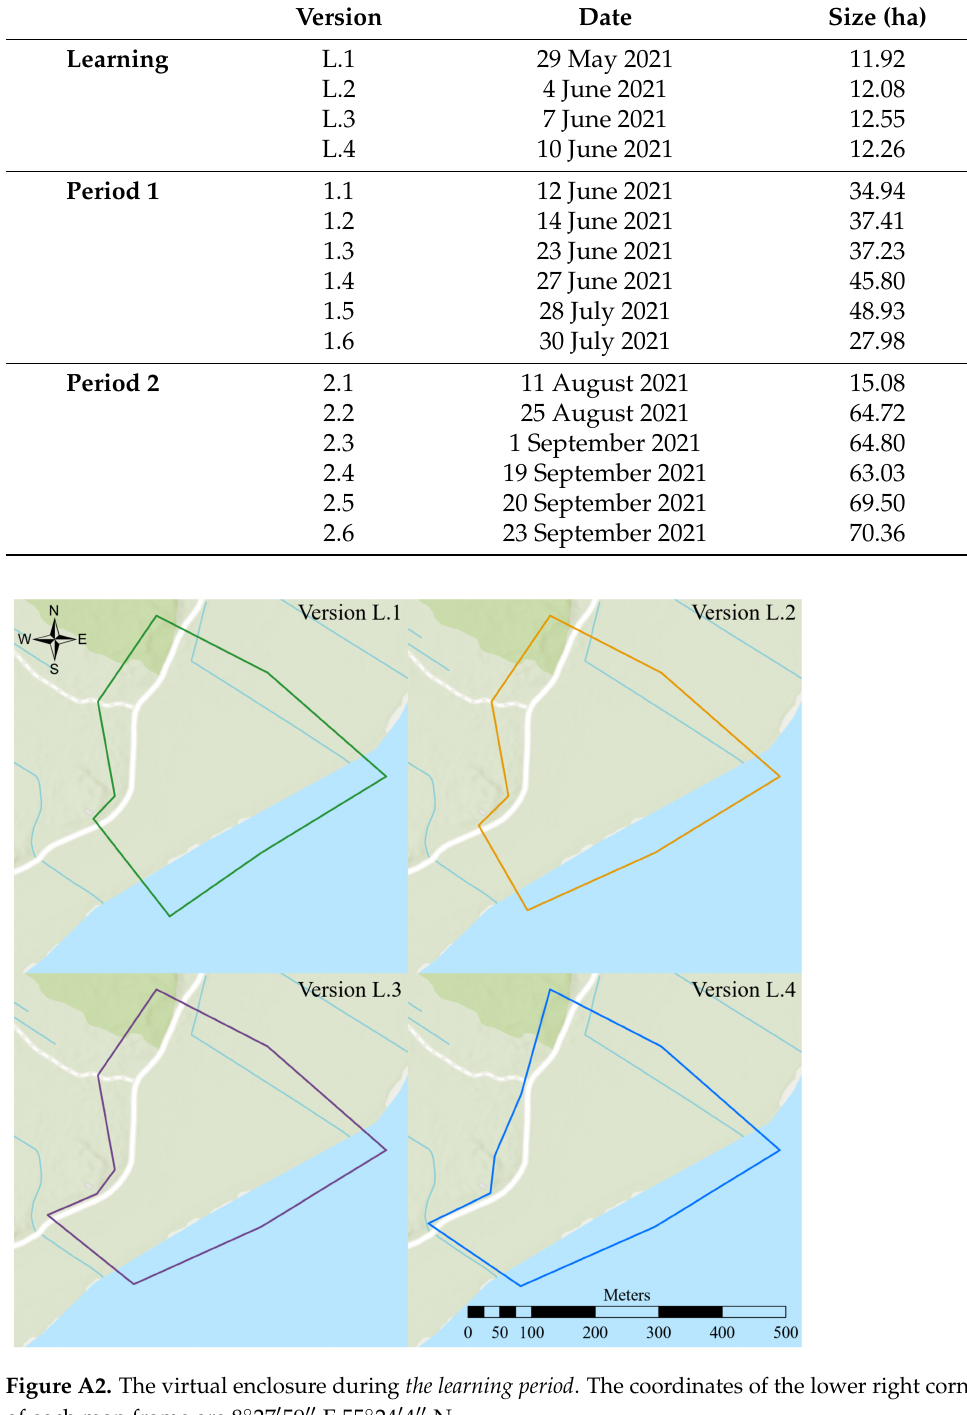
Table A1. Activation date and effective size of each version of the virtual enclosure. Each version of the enclosure was active from the date specified in the table until the next version was created. Only versions of the enclosure that were in effect for more than 12 h are included.